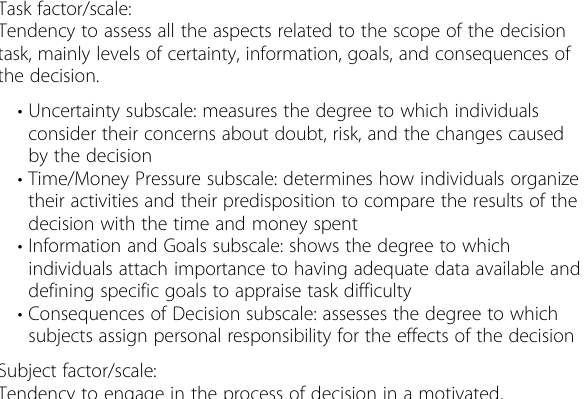
Table 1 DMQ (Decision-Making Questionnaire) scales and